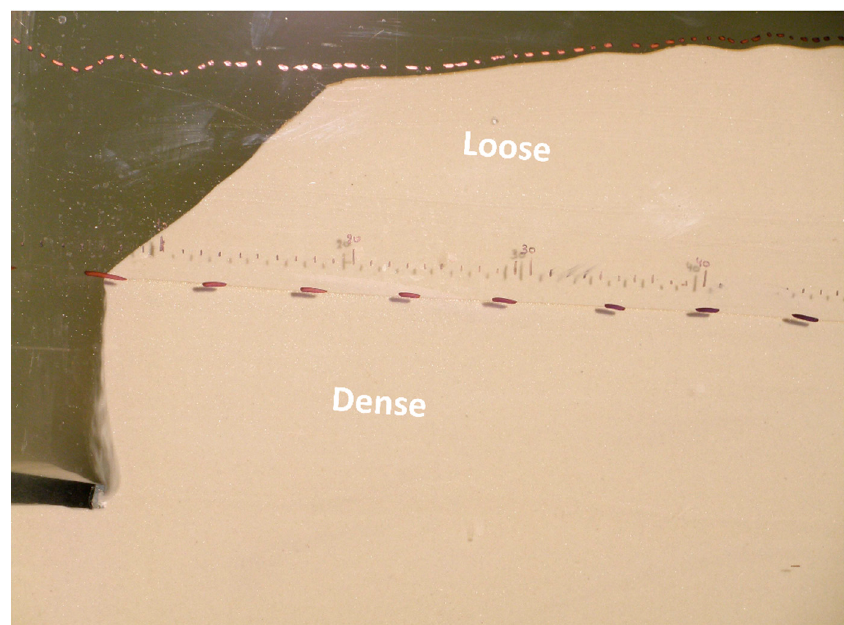
Figure 14. Small-scale breaching test in fine sand. Upper layer loosely packed, lower layer densely packed fine sand (d 50 = 120 µm, slope height 40 cm). Retrogression velocity 1–2 mm/s. The sand produced by the breach is removed by suction (left). Photo: M. Busink.